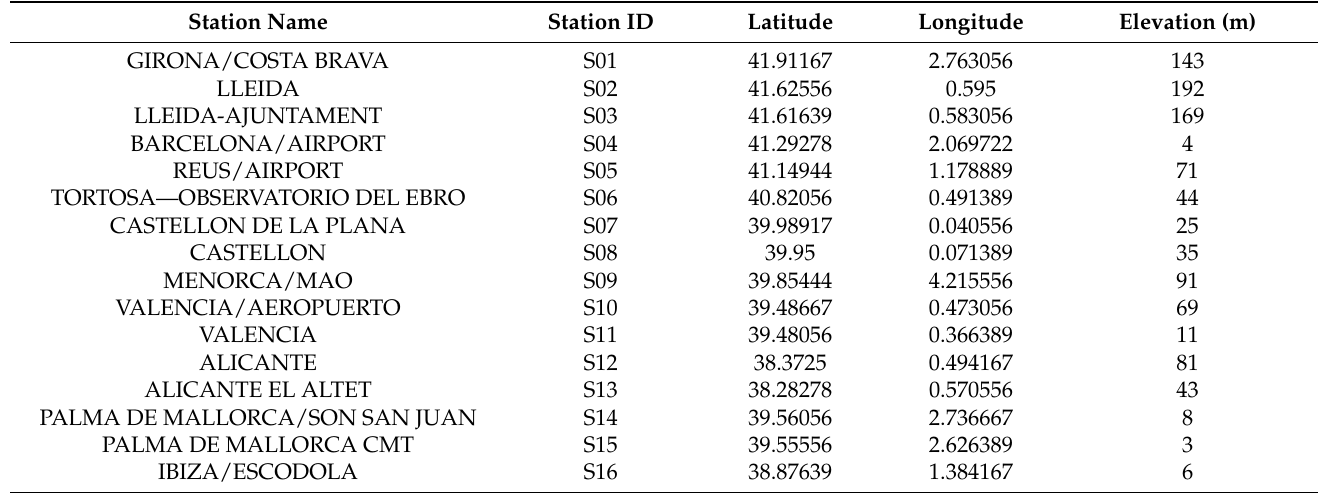
Table 1. Weather stations used and their location.